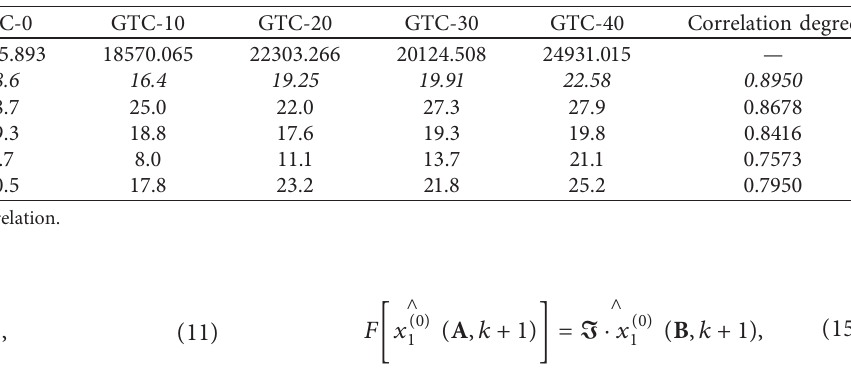
Table 8: Most grey correlation of resistivity of GTC 0% to 40%.